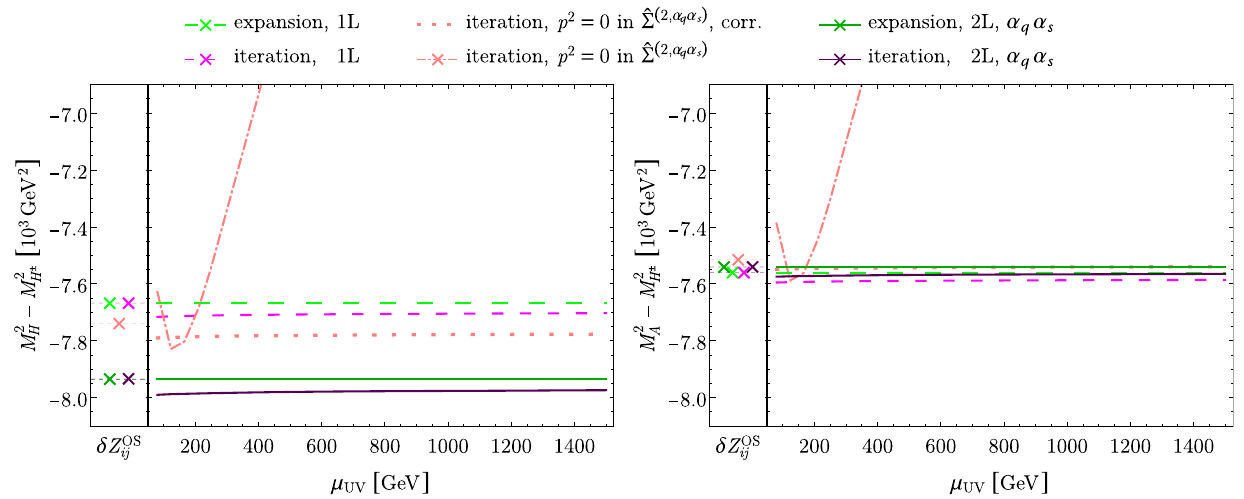
Fig. 4 Dependence on the field counterterms at 1L order and O (α q α s ) for M H ± = 2 . 5TeV. The conventions are similar to those of